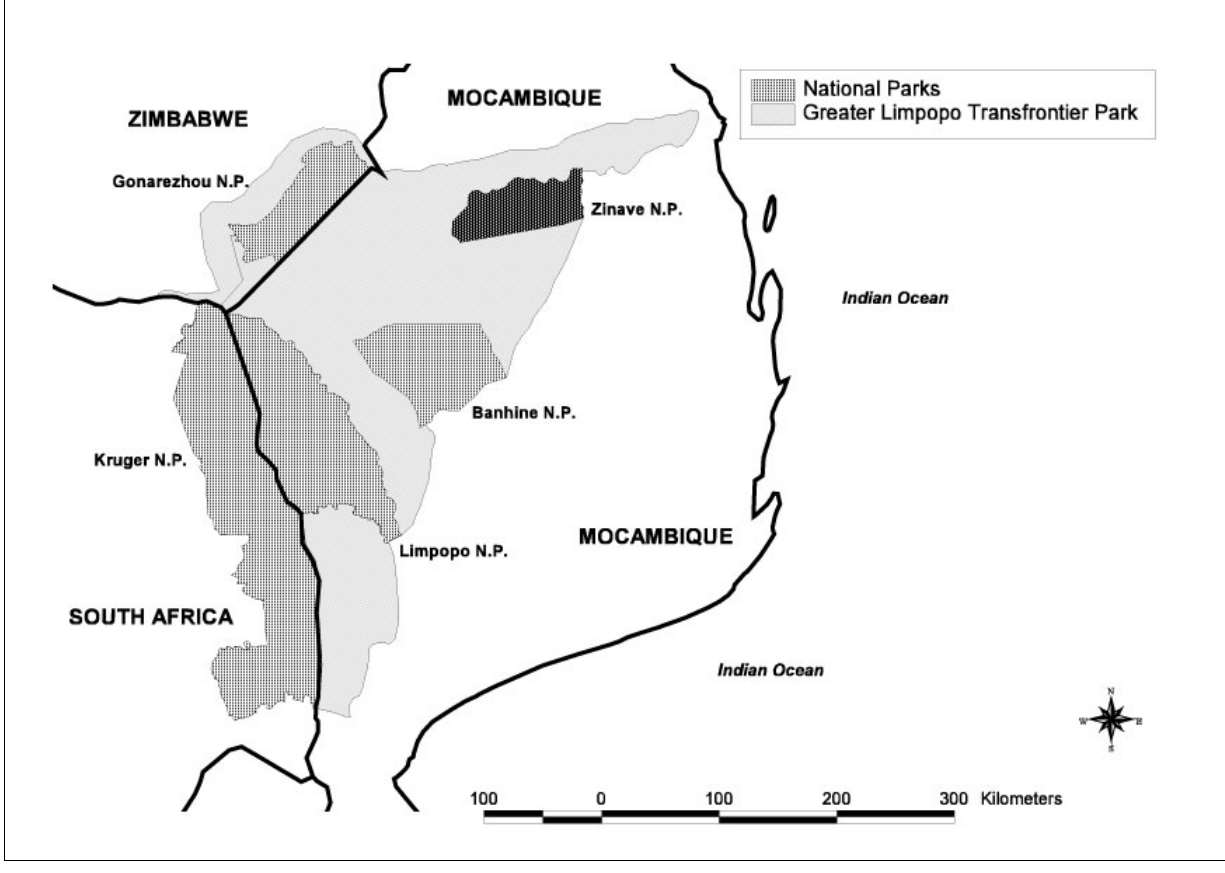
FIGURE 1 Locality map of the Parque Nacional de Zinave in the Greater Limpopo Transfrontier